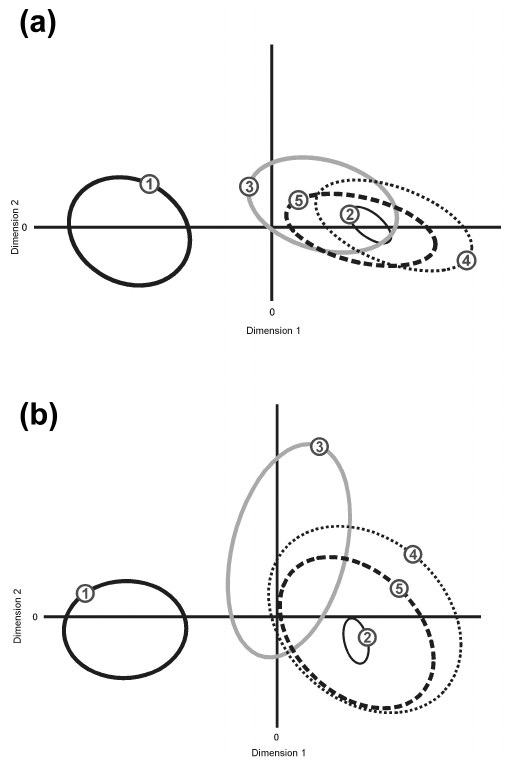
Figure 3. Contour plots summarising, per breed, the informa- tion provided by the 11 qualitative traits analysed via correspon- dence analyses. Contours show the 75% confidence region of the within-breed relationships among individuals. Correspondence di- mension 1 is on the x axis and correspondence dimension 2 on the y axis. Panel (a) corresponds to the female subset and (b) cor- responds to the sires subset. Numbers on contours mean the fol- lowing: (1) Zebu Bororo; (2) Zebu Azawak; (3) Zebu Mbororo; (4) Zebu Peul of Burkina Faso; and (5) Zebu Peul of